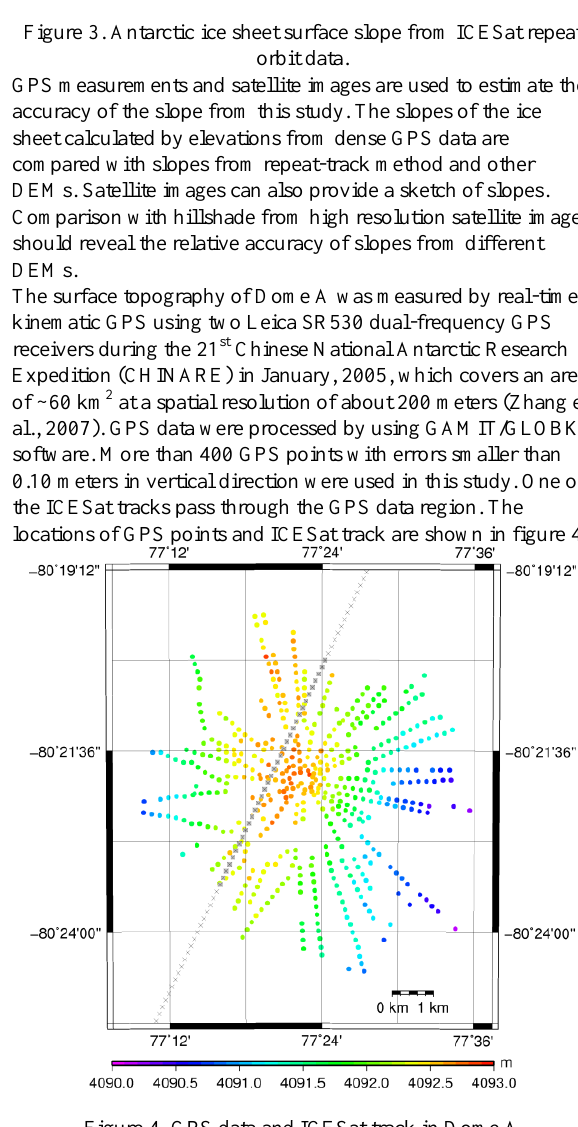
Figure 4. GPS data and ICESat track in Dome A